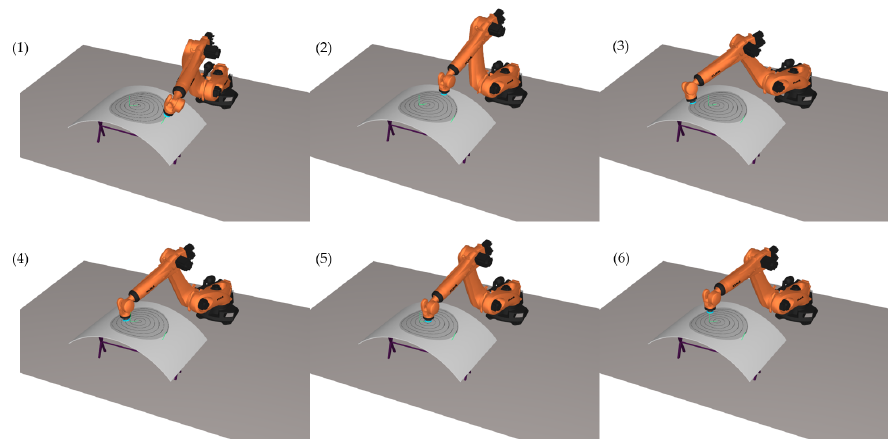
Figure 20. The grinding process of the defect area.